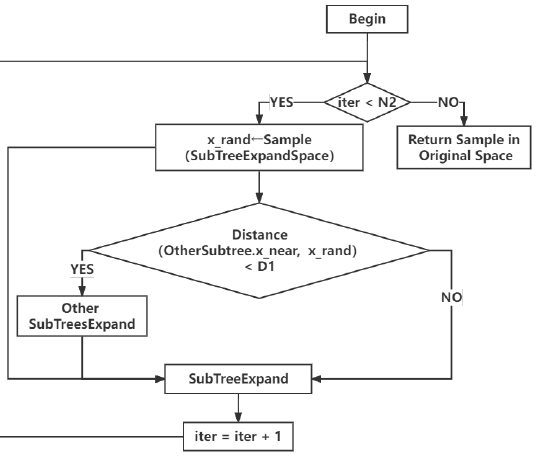
Figure 6. Schematic of SubTree